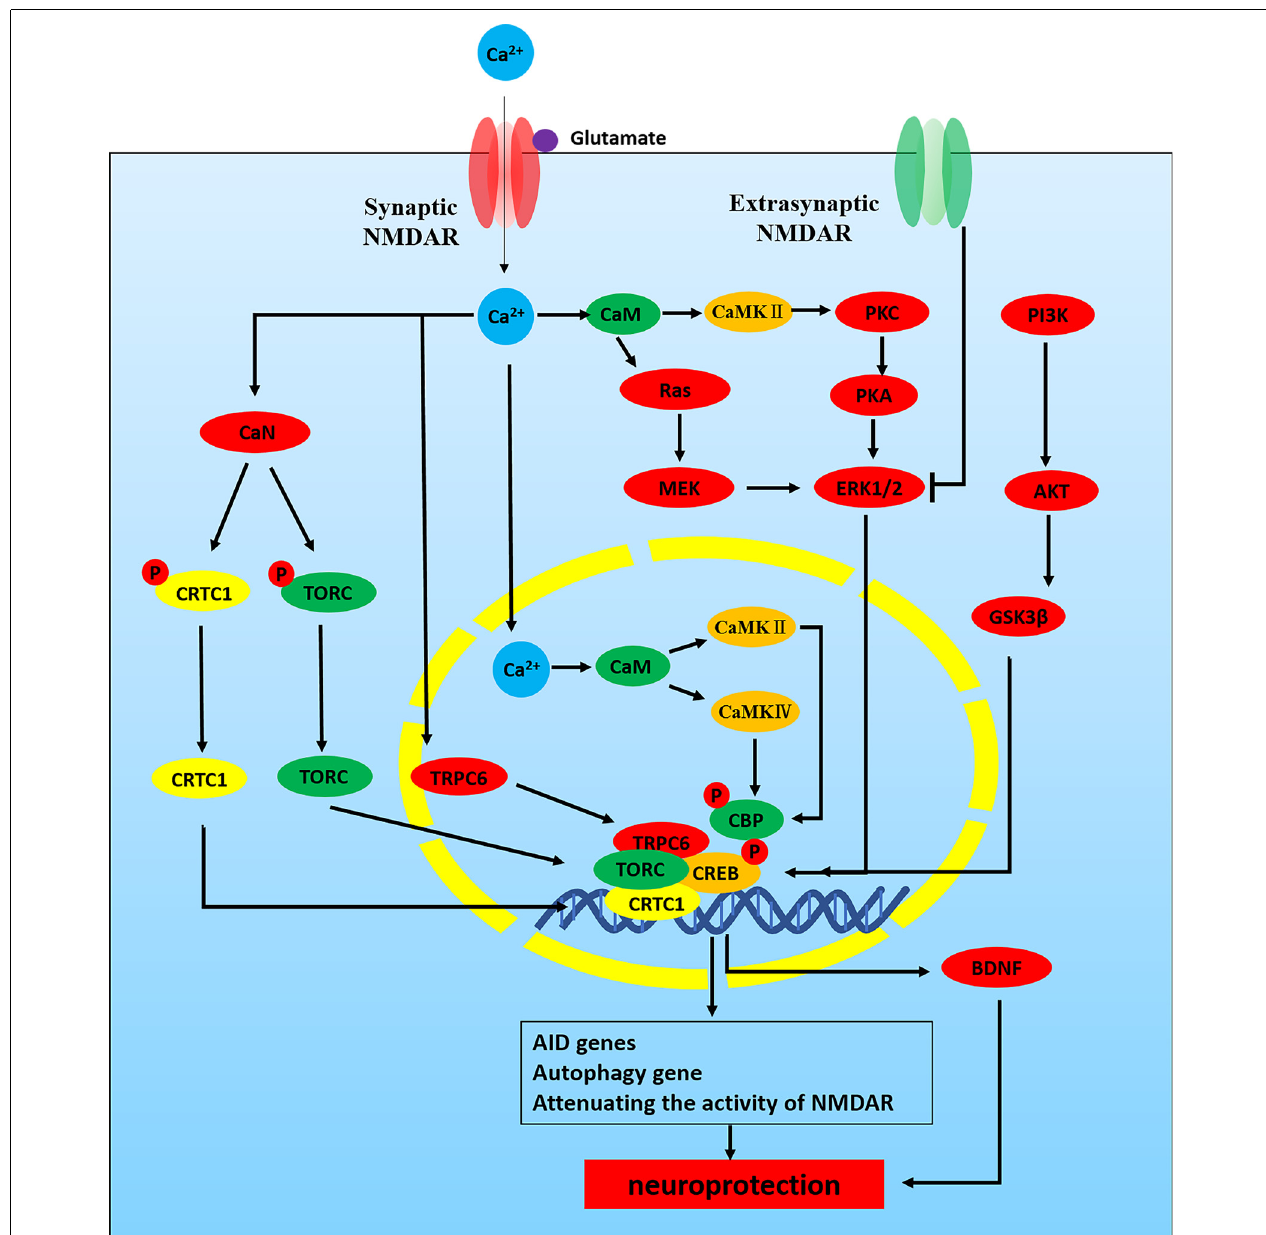
FIGURE 3 | NMDAR -Ca 2+ -CREB signaling pathways in neuroprotection. NMDAR activity can activate CREB-dependent gene expression. CREB must be phosphorylated at serine-133 in order to recruit its co-activator CREB binding protein (CBP). Phosphorylation of CREB is mediated by the fast-acting nuclear Ca 2+ /CaMK pathway and the slower acting, longer lasting Ras-ERK1/2 pathway, both of which are promoted by activation of synaptic NMDARs. (1) Nuclear Ca 2+ -CaM-CaMKIV/CaMKII-CREB: nuclear Ca 2+ -dependent CaMKIV/CaMKII phosphorylates CBP at serine-301. (2) ERK1/2-CREB: CBP is also phosphorylated by Ras-MEK-ERK1/2 pathway or CaMKII/PKC/PKA-ERK1/2 pathway. CREB phosphorylated at serine-133 recruits its CBP. In addition, nuclear translocation of TORC activity is a key step in CREB activation. (3) Ca 2+ -TORC-CREB: synaptic NMDAR-induced Ca 2+ signals promote TORC import into the nucleus by